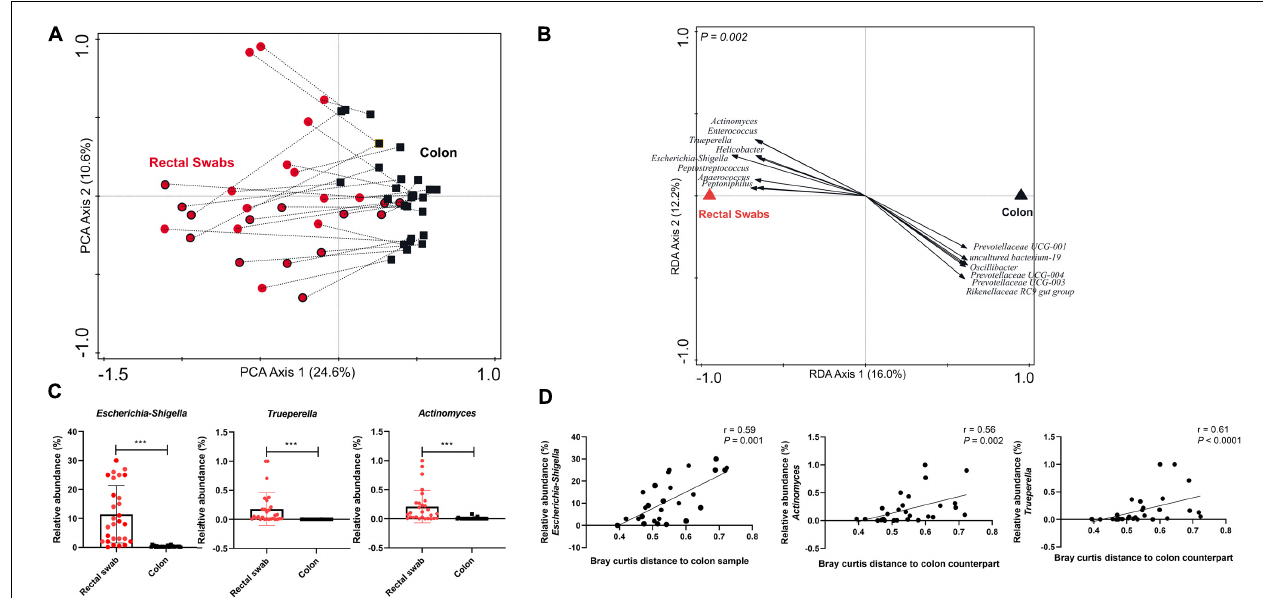
FIGURE 1 | Evaluating microbiota composition (genus level) in paired rectal swabs and colon samples, collected from the same animals at weaning (29 days of age). (A) Principal Component Analysis (PCA) of rectal swab (red circles; early fed piglets: red circles with black border) and colon (black squares) microbiota, with paired samples (i.e., collected from the same animal) joined by dotted lines. (B) Redundancy analysis (RDA) of rectal swab and colon samples (adjusted explained variation = 14.5%; P = 0.002), displaying discriminating microbial groups (response score > 0.60). (C) Bar plots displaying relative abundance of representative microbes enriched in the rectal swab samples compared to the colon samples (Mann–Whitney t test; *** P < 0.0001). (D) Spearman correlation between the relative abundance of representative microbes in the rectal swab sample and the (squared Bray Curtis) distance of the rectal swab with respect to its paired colon sample.